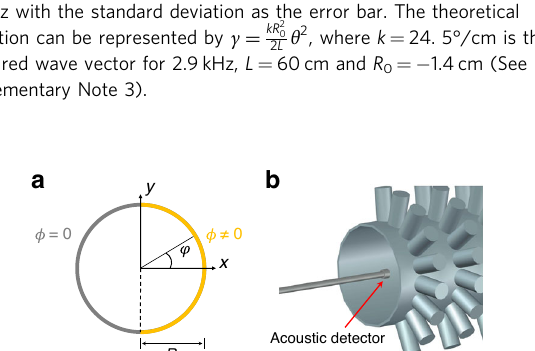
Methods Spin angular momentum in the metasurface waveguide . In the cylindrical coordination system ( r , φ , z ) as shown in Fig. 7a, the solution of the acoustic fi eld in the metasurface waveguide mode will be the linear composition of the Bessel function J l ( r ) as: p = p 0 ∑ l c l J l ( κ r ) e il φ e i ( kz − ω t ) , where c l is the modal amplitude, ffiffiffiffiffiffiffiffiffiffiffiffiffiffi q ω 2 κ ¼ (cid:4) k 2 , k = k e z is the longitudinal wave vector along the z direction, ω is the c 2 frequency and c is the sound speed in the air. Due to the nonsymmetric boundary conditions in Fig. 7a, we will have: p r = R = 0 for φ ∈ [ − π /2, π /2] and ∂ r p ∣ r = R = 0 for φ ∈ [ − π , − π /2) ∪ ( π /2, π ], where R is the radius of the waveguide. For the lowest order state for the metasurface waveguide, we consider only l = 0, ±1 here. After some maths, the acoustic pressure fi eld for the ground state in the metasurface